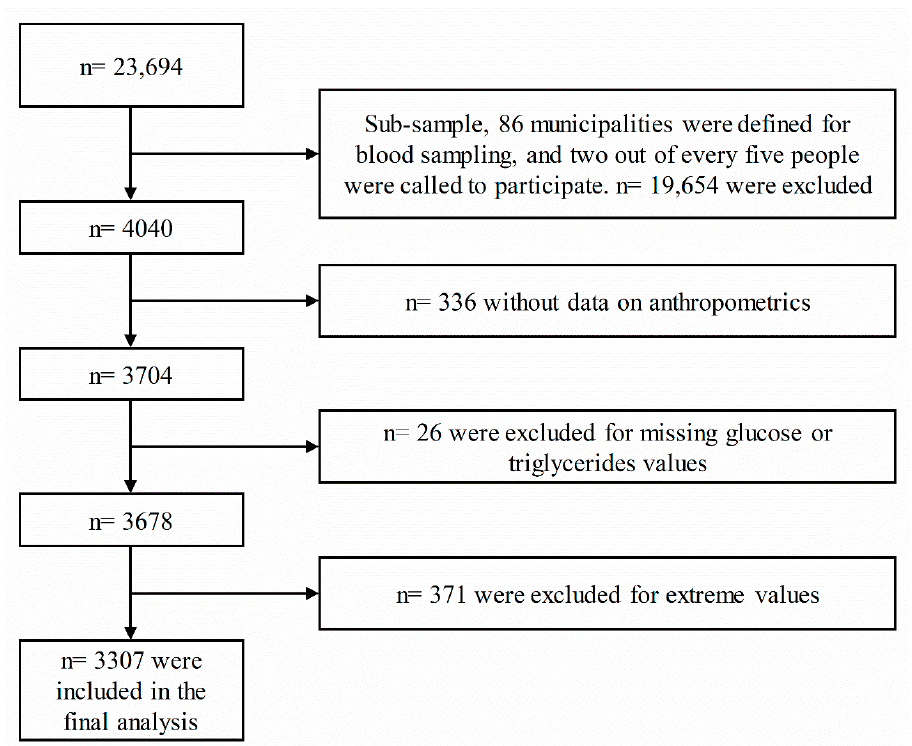
Figure 1. Flow chart showing the selection of the study sample from the Colombian Health and Wellbeing and Aging Survey (SABE) 2015. All analyses presented in this paper were based on 3307 surveyed participants, each with complete anthropometric, blood-based indicator, and covariable data.